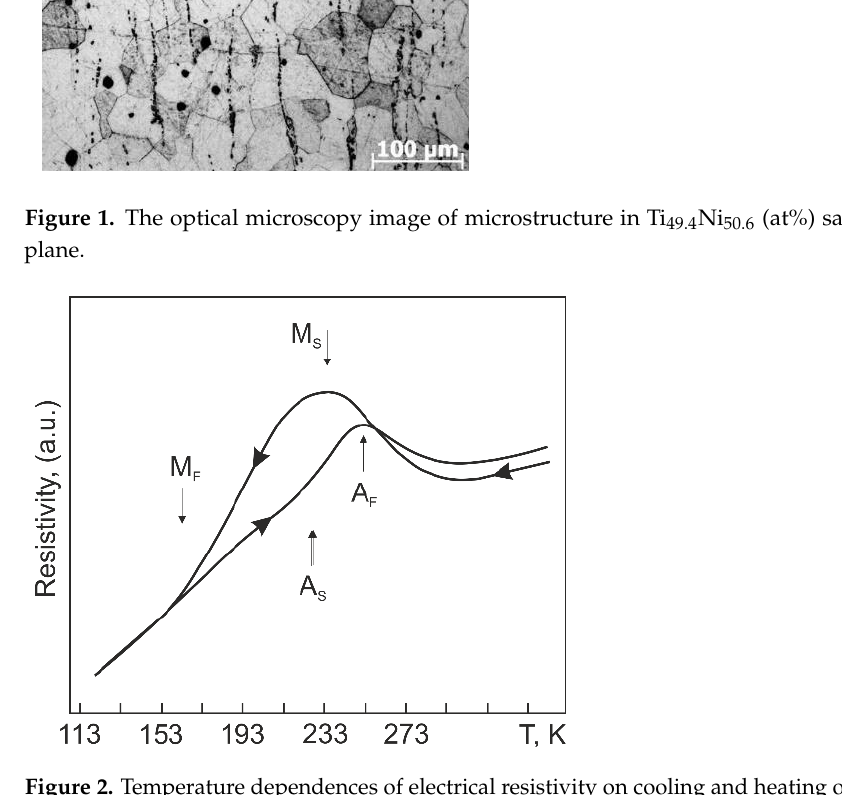
Figure 2. Temperature dependences of electrical resistivity on cooling and heating of initial samples.